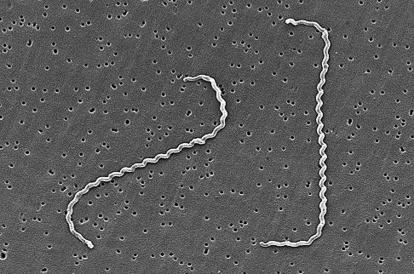
Scanning Electron Micrograph of Leptospira interrogans (Strain RGA)The image shows two spirochetes bound to a 0.2-μm filter. Strain RGA was isolated in 1915 by Uhlenhuth and Fromme from the blood of a soldier in Belgium.(Image: CDC/NCID/HIP/Janice Carr)